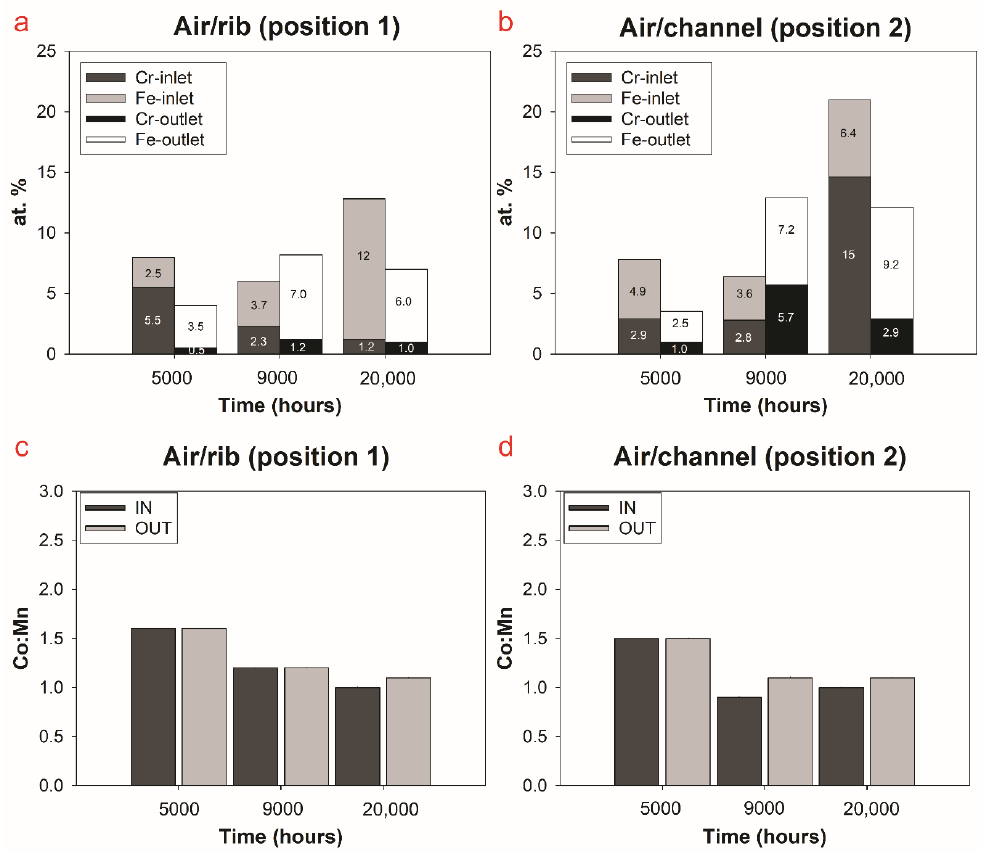
Figure 6. Histograms of Cr and Fe content (at.%) and Co:Mn inside the coating according to the operating time and site of interest (IN, OUT): ( a ) stacked Fe and Cr position 1; ( b ) stacked Fe and Cr position 2; ( c ) Co:Mn position 1; ( d ) Co:Mn position 2.